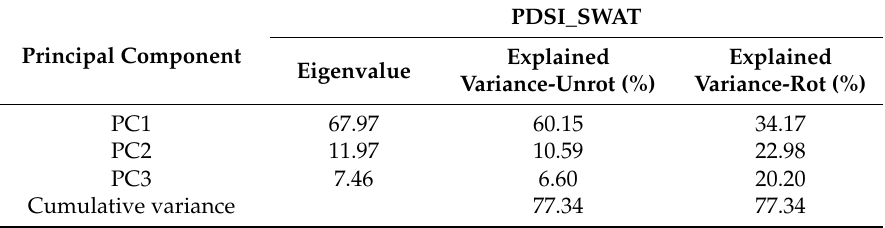
Table 4. Principal component analysis on the PDSI_SWAT for the 113 sub-basins across the whole